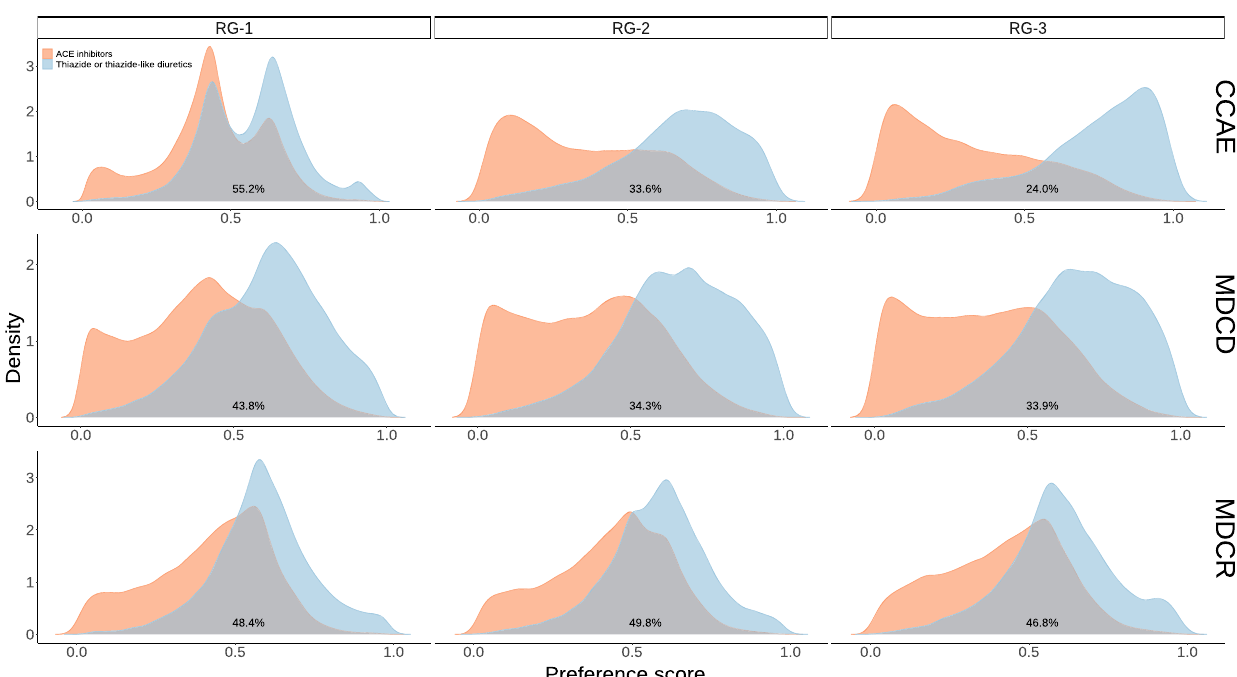
Fig. 2 Preference score distributions within strata of predicted acute MI risk. RG-1 represents patients with acute MI risk lower than 1%; RG- 2 represents patients with acute MI risk between 1% and 1.5%; RG-3 represents patients with acute MI risk larger than 1.5%. The preference score is a transformation of the propensity score that adjusts for prevalence differences between populations. The percentages in each fi gure represent the amount of preference score overlap between treatment arms. Higher overlap of the preference score distributions indicates that patients in the target and the comparator cohorts are more similar in terms of the predicted probability of receiving treatment (thiazide or thiazide-like diuretics).